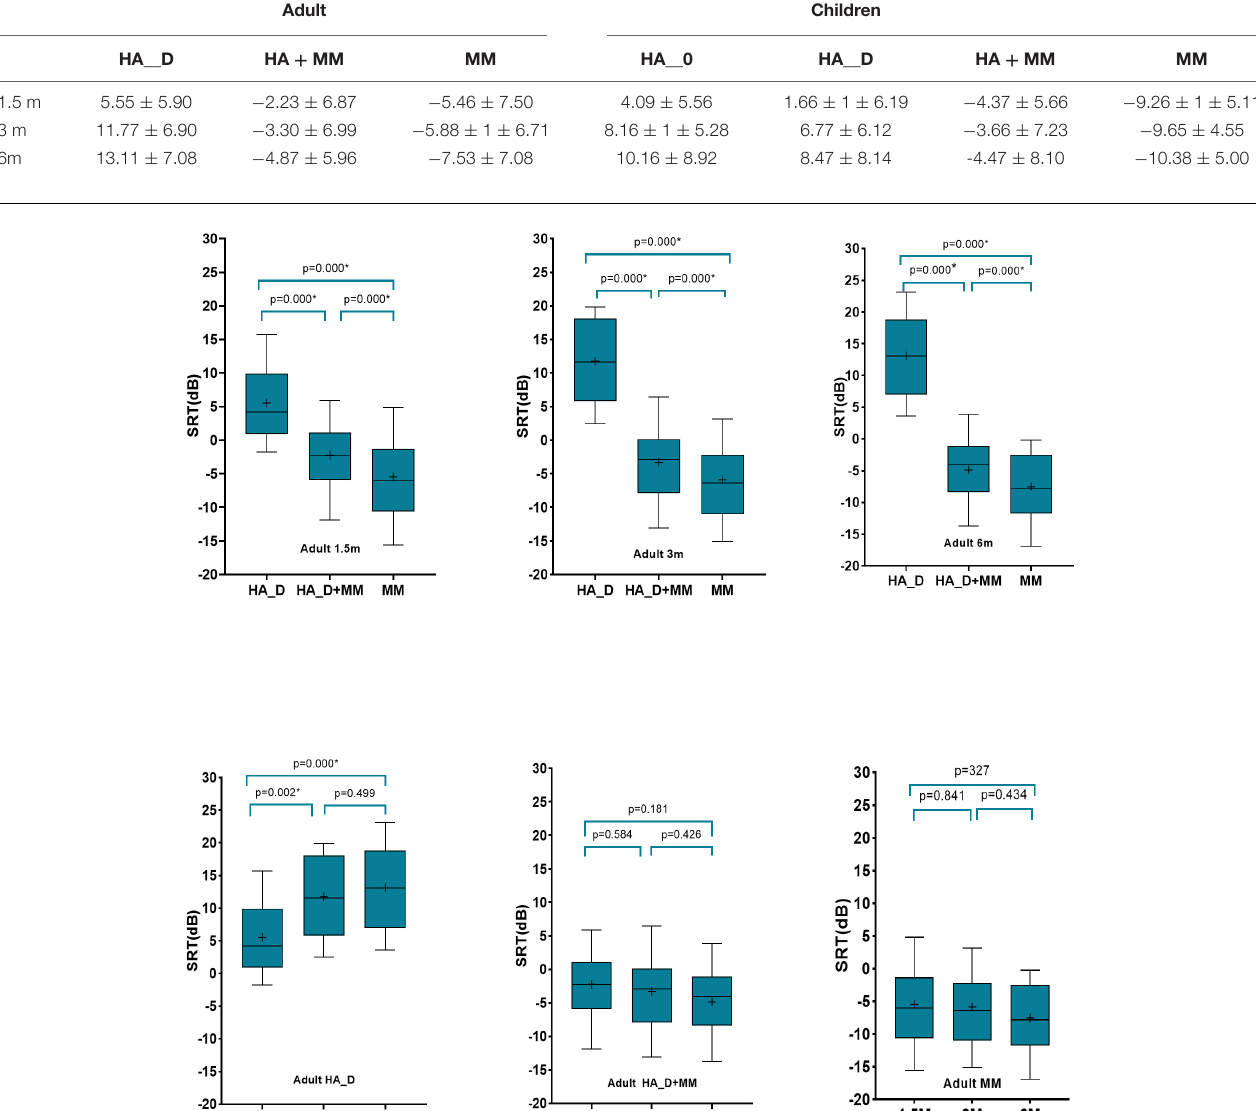
TABLE 1 | The speech in noise recognition thresholds in SNRs (dB) obtained under each test condition for both adults and children. Adult